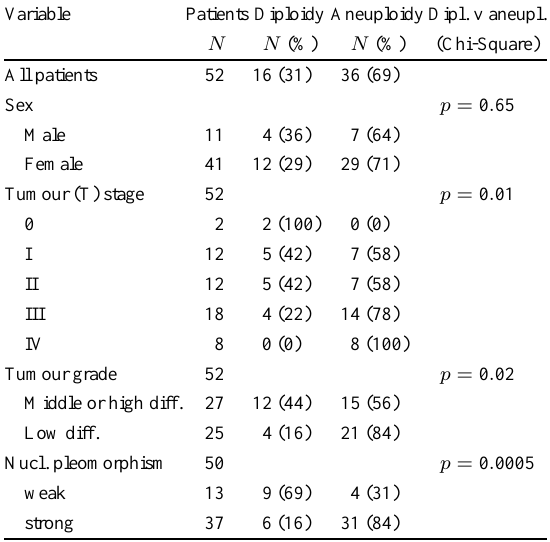
Basal clinical data and DNA ploidy in 52 patients with gallbladder cancer Variable Patients Diploidy Aneuploidy Dipl. v